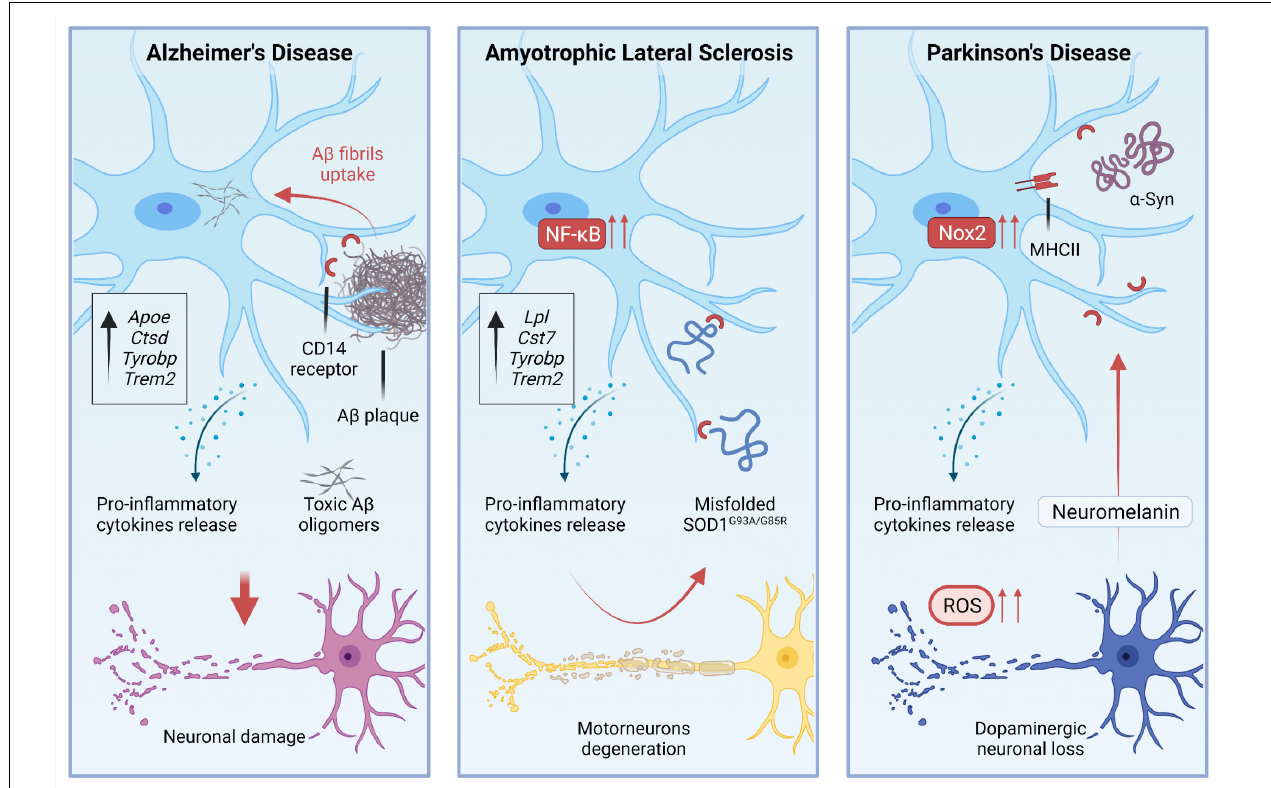
FIGURE 2 | During pathological processes, microglial activation is involved in the disease progression, residing in a chronic state of